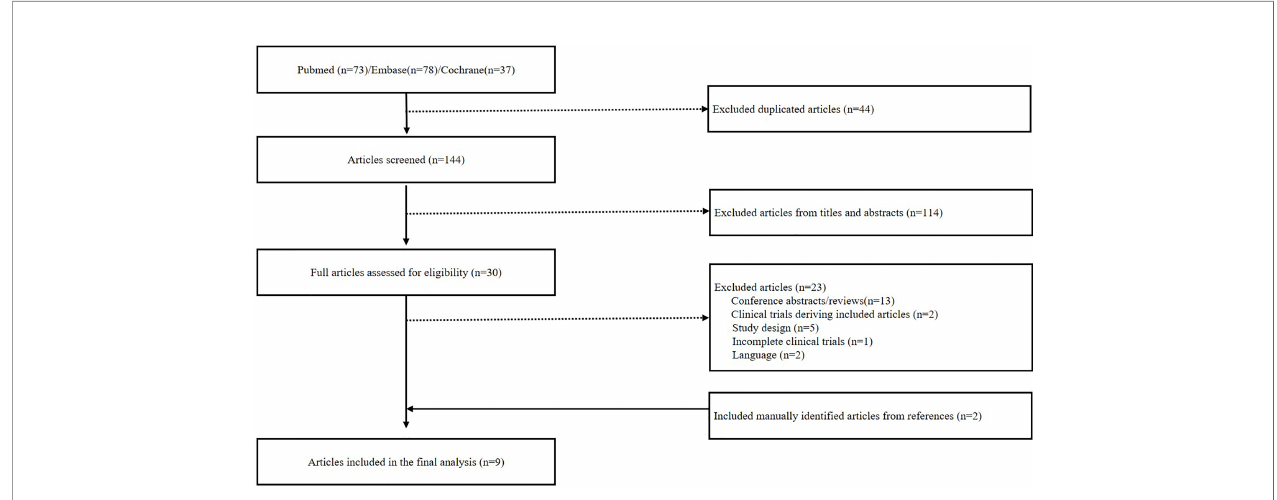
FIGURE 1 | Flow chart of literature search and